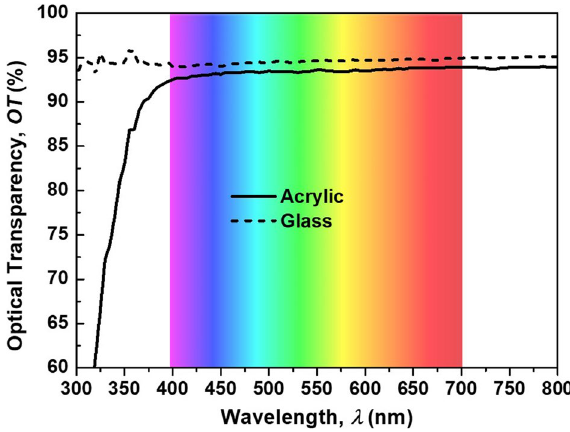
Figure 1. A correct version of the original Figure 3a.